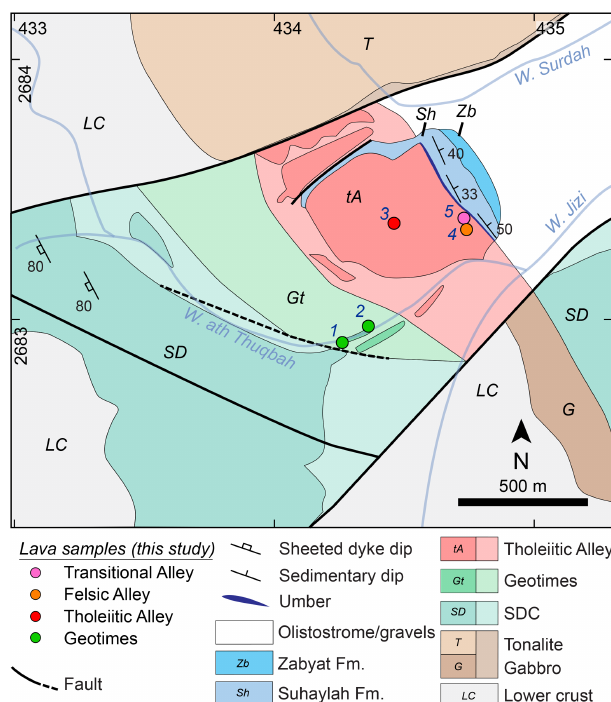
Figure 14. Mapping example: the fault-bounded north-east-dipping volcanic section at Suhaylah, modified after Robertson and Wood- cock (1983) and BME (1987c), showing Tholeiitic Alley lavas (this study) overlying a thin Geotimes section and underlying the type- locality Suhaylah sediments. Our samples analysed to prove unit affiliations are numbered: (1) SP18-A1, (2) SP18-A3, (3) TB4-17J, (4) SP18-A8, and (5)